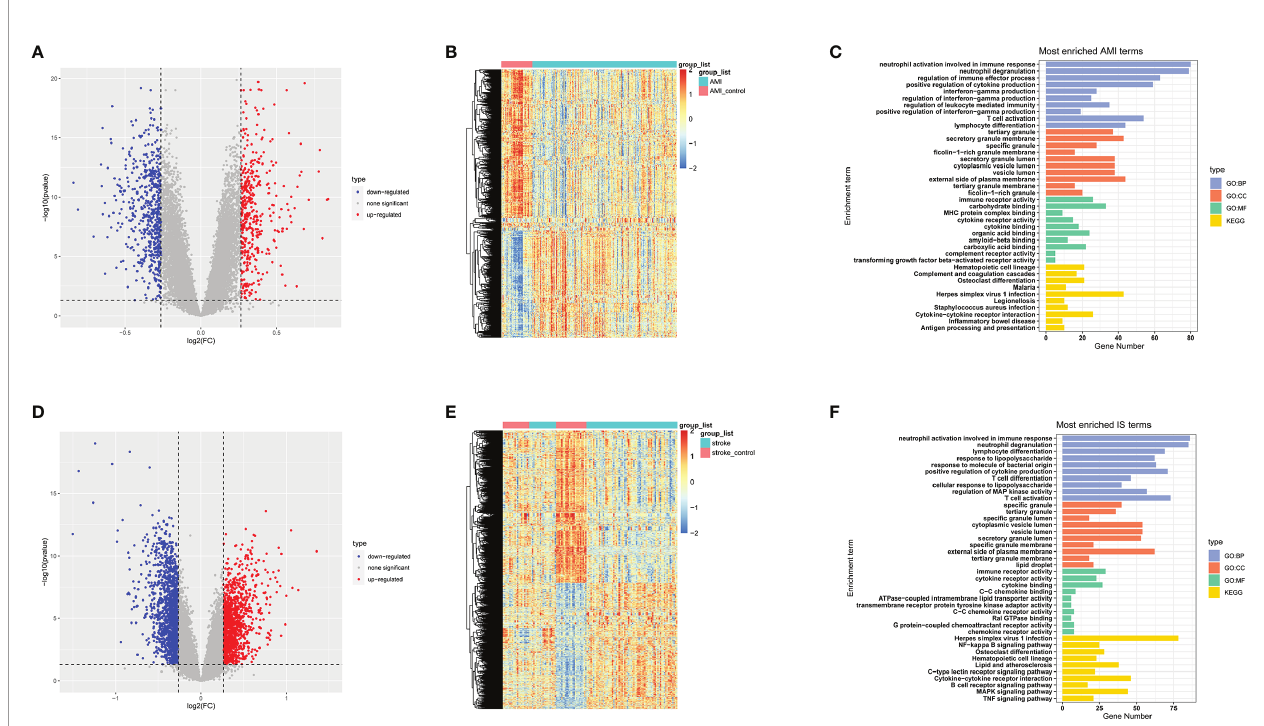
FIGURE 2 | Data preprocessing, DEG identi fi cation, and enrichment analyses. (A) Volcano plots of DEGs in AMI. (B) Heatmaps of DEGs in AMI. (C) GO and KEGG enrichment analyses in AMI. (D) Volcano plots of DEGs in IS. (E) Heatmaps of DEGs in IS. (F) GO and KEGG enrichment analysis in IS. Statistical signi fi cance was determined by hypergeometric distribution analysis and the P -values were calculated by Fisher ’ s exact test. CC, cell component; BP, biological process; MF, molecular